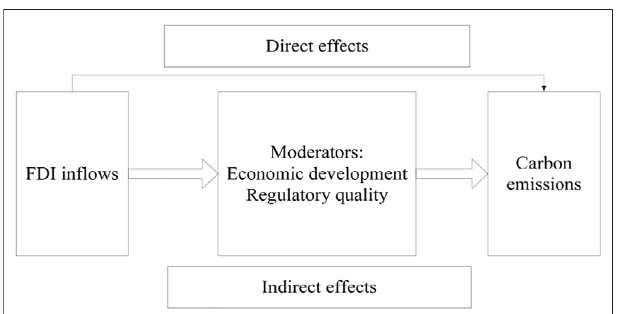
FIGURE 1 | Theoretical